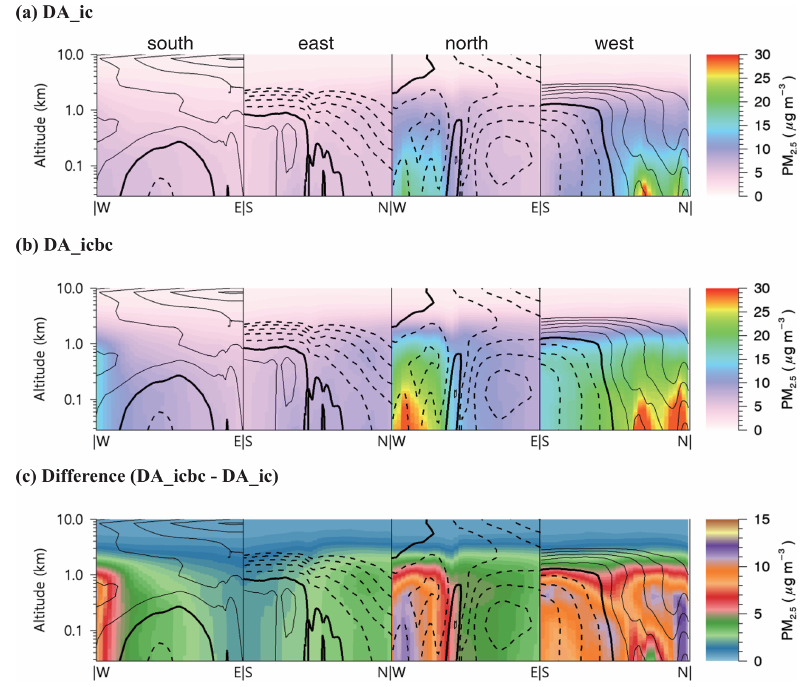
Figure 6. Averaged PM 2 . 5 distributions in the four lateral boundaries of the domain 2 (D2: south, east, north, and west from the left to the right, refer to Fig. S4 of the Supplement). Each panel includes black contour lines that explain the inflow (solid lines) and outflow (dashed lines) wind vector with 1ms − 1 intervals. The thick black lines indicate zero wind speed. In (a) DA_ic and (b) DA_icbc, the averaged lateral boundary conditions are provided into D2 without and with the EnKF data assimilation in China (D1), respectively. The increments in DA_icbc experiment are also presented in the bottom panel (c) . Note that the y axis for altitude is presented in log scale to emphasize the results below the boundary